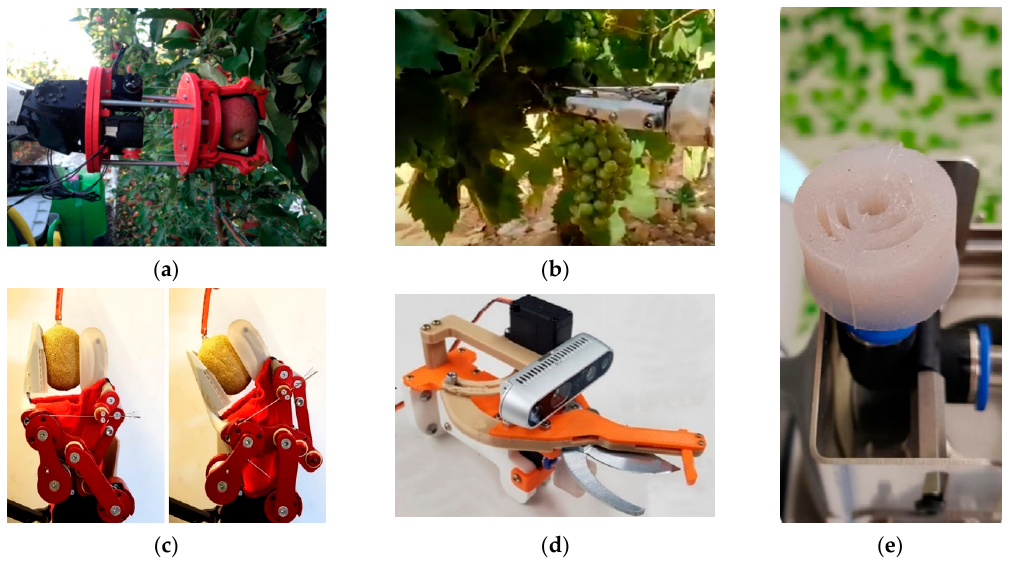
Figure 2. Indicative harvesting end-effector types: ( a ) contact-grasping gripper/fruit-holding (Reprinted/adapted with permission from Ref. [22]. 2017, Silwal, A.), ( b ) contact-grasping gripper/stem-holding [23], ( c ) rotation mechanism (Reprinted/adapted with permission from Ref. [20]. 2019, Williams, H.A.M.), ( d ) scissors/sawlike tool (Reprinted/adapted with permission from Ref. [24]. 2021, Jun, J.), (e) s uction device (Reprinted/adapted with permission from Ref. [24]. 2021, Jun, J.).